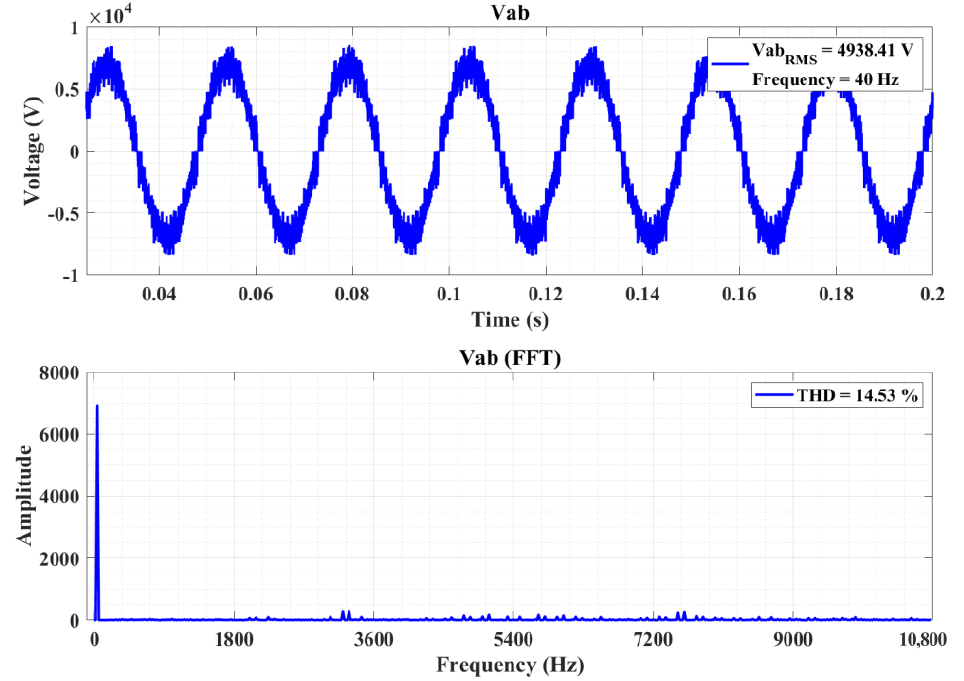
Figure 12. Line voltage and MMMC harmonic